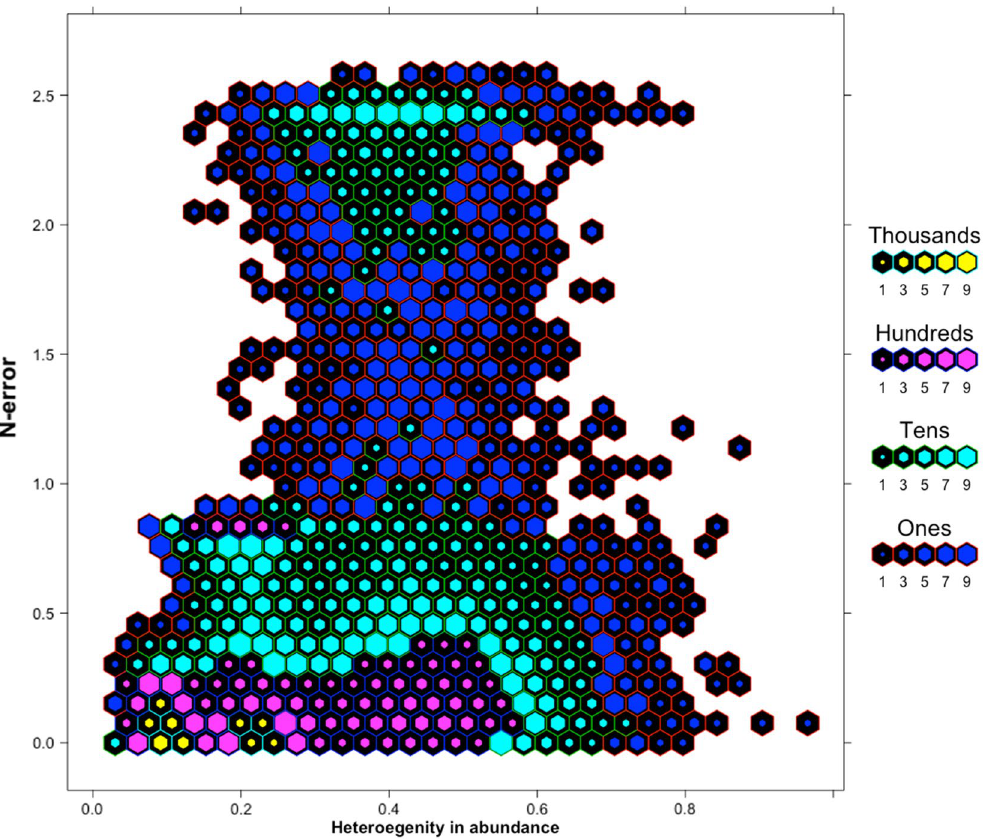
Figure 6. Scatterplot of the relationship between heterogeneity in abundance and the absolute value of error in abundance estimation for stable population scenarios. Hexagonal bins represent the number of points falling within each